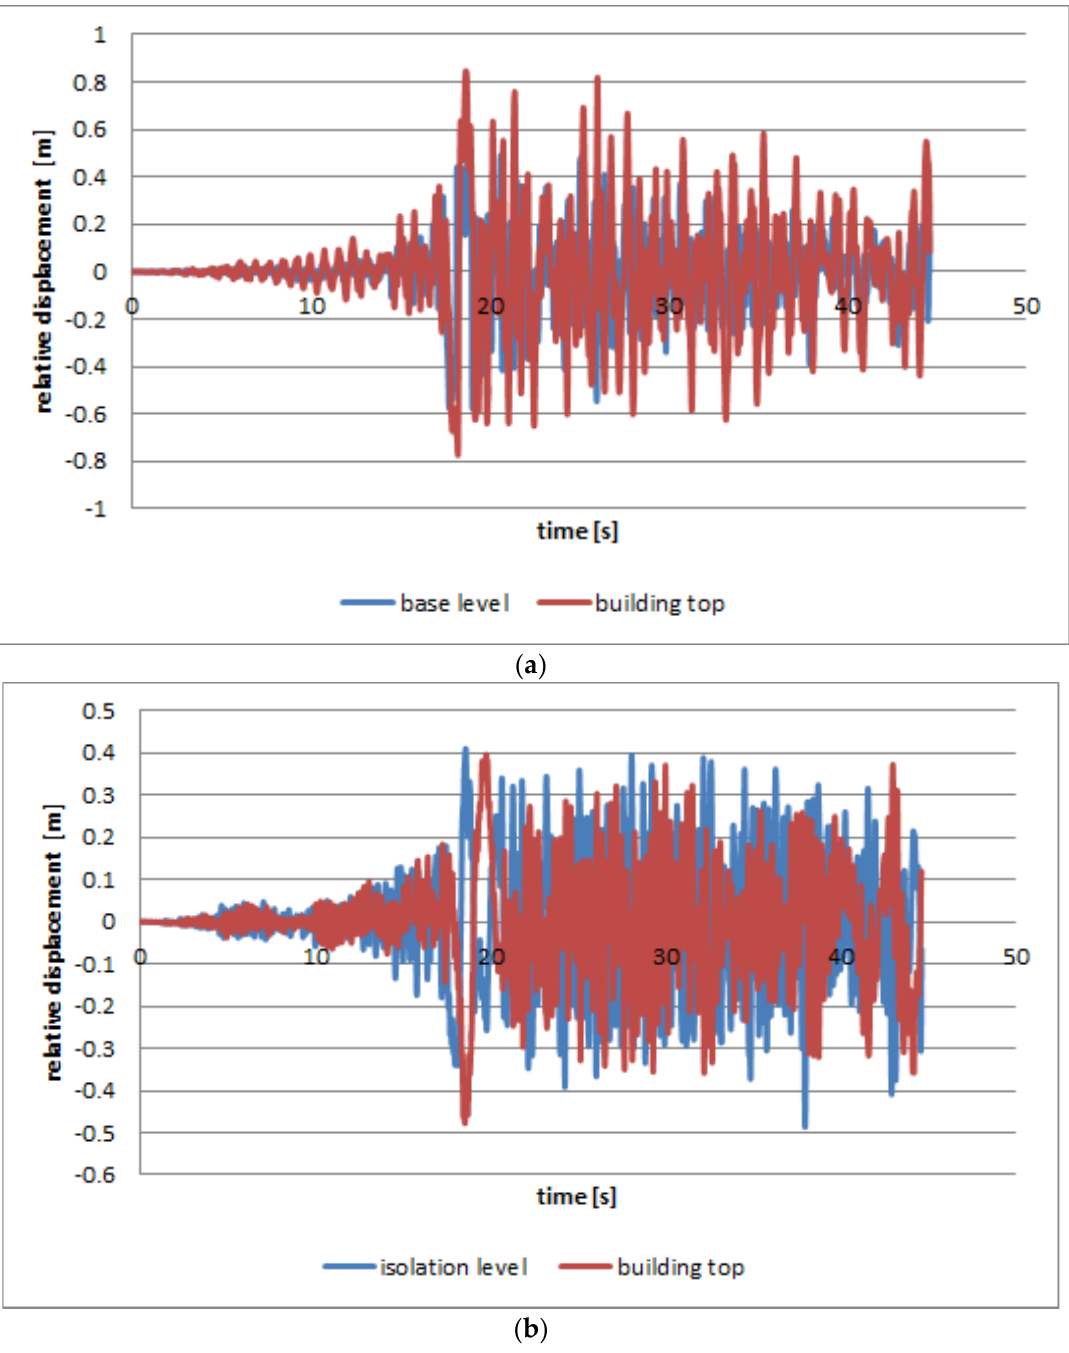
Figure 10. Relative displacement [m] time histories, INCERC 1977 spectrum compatible ground acceleration record: ( a ) classic building; ( b ) base-isolated structure.